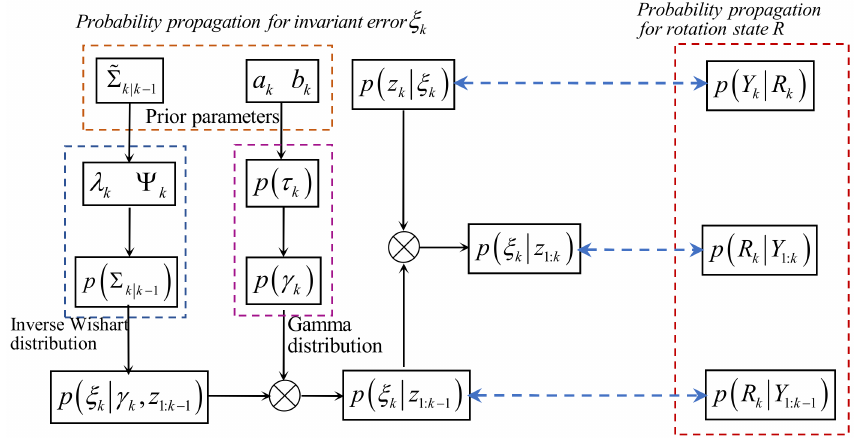
Figure 6. Probability view of the proposed filtering method for Student’s t based hierarchical Gaussian state-space